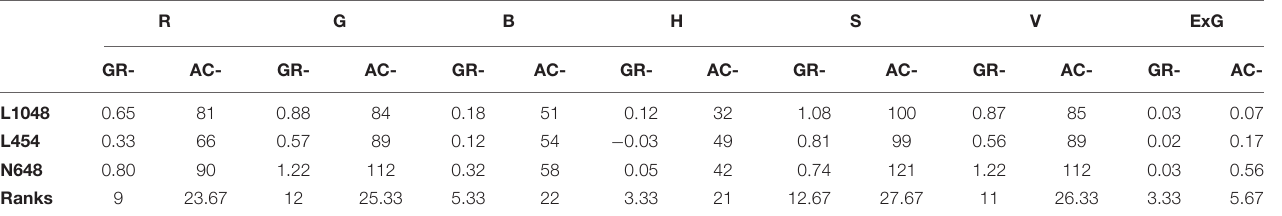
TABLE 6 | Color-related dynamic traits of lettuce